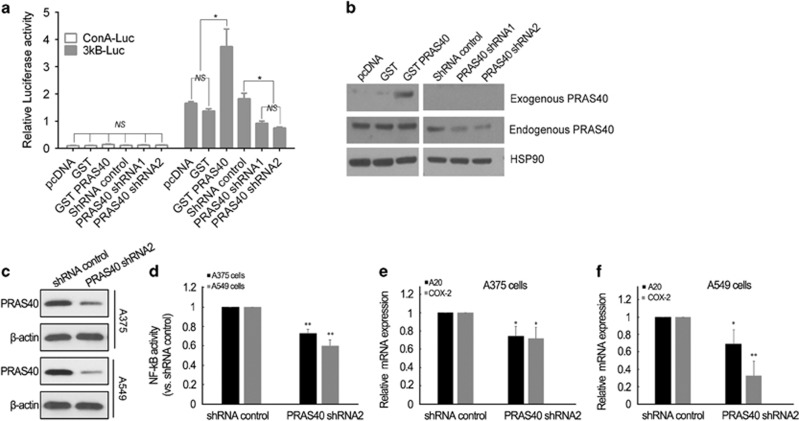
PRAS40 regulates NF-κB transcriptional activity. (a) Dual Luciferase Reporter assay of NF-κB transcriptional activity. ConA-Luc and 3κB-Luc was the Firefly plasmid for the control and reporter, respectively. Renilla was transfected for the endogenous control for the experiment. The ratio of Firefly to Renilla is presented on the y axis. The activity of 3κB-Luc in the cells expressing GST-PRAS40 was significantly enhanced relative to cells transfected with the GST control and pcDNA (P<0.001). Two PRAS40-targeted shRNAs significantly decreased the relative activity of 3κB-Luc compared with control shRNA (P<0.01). There were no significant differences of relative activity between the groups of ConA-Luc. NS=P>0.05, *P<0.05. (b) In order to determine the transfection efficiency, the cell lysates were analyzed by western blotting. HSP90 was used as a loading control. (c) Confirmation of PRAS40 knocking down in melanoma A375 and lung cancer A549 cells. (d) Knocking down of PRAS40 suppressed NF-κB p65 DNA-binding activity in both A375 and A549 cells. Data are expressed as mean±s.d. *P<0.05, **P<0.01. (e, f) Knocking down of PRAS40 downregulated A20 and COX-2 mRNA levels in A375 (e) and A549 (f) cells. Data are expressed as mean±s.d. *P<0.05, **P<0.01.